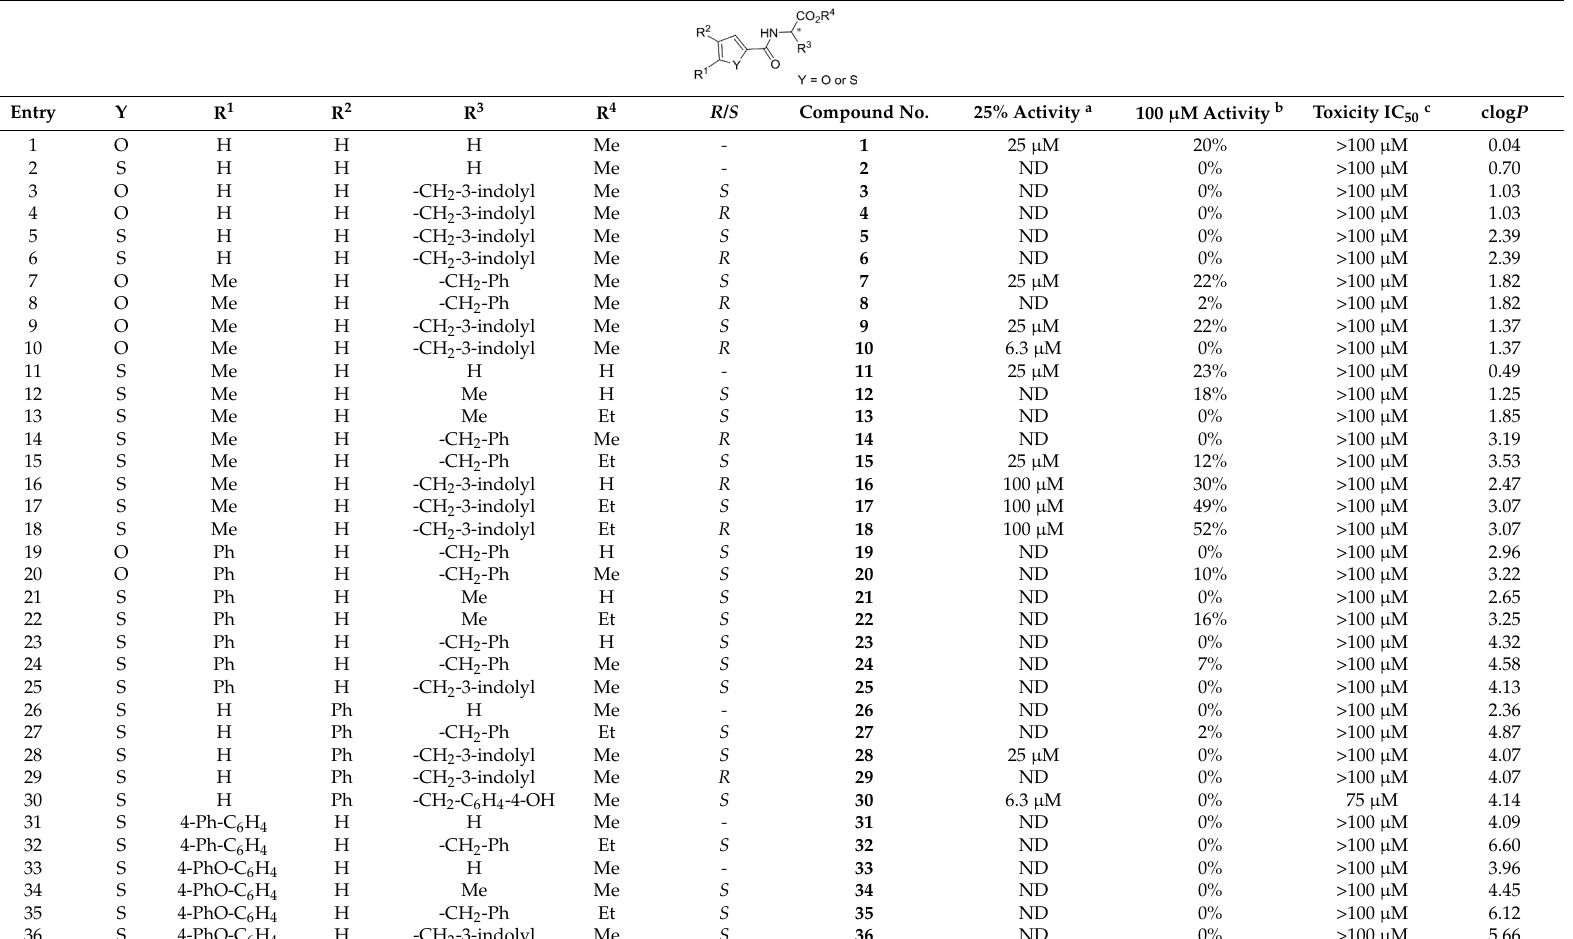
Table 1. Evaluation of HIF activity by several furan- and thiophene-2-carbonyl amino acid derivatives, their toxicity, and their partition